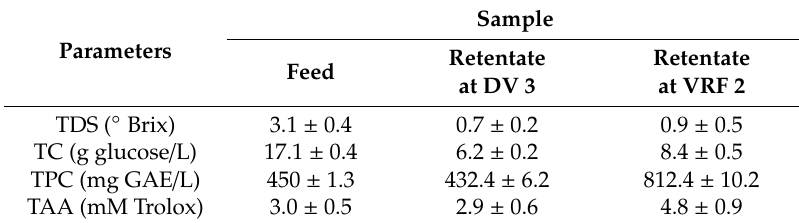
Chemical composition of the clarified Goji berries extract before and after the diafiltration / concentration process with the GH